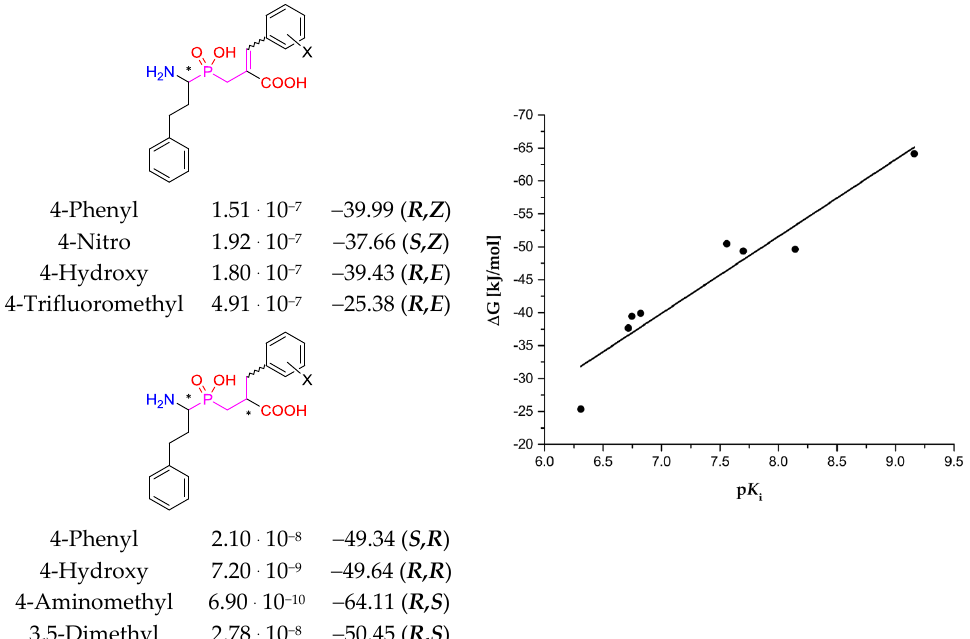
Figure 11. Correlation plot of inhibitory activity of bestatin (p K i ) reported for different metallo- aminopeptidases with the corresponding values of the calculated free Gibbs energy (R 2 = 0.65).